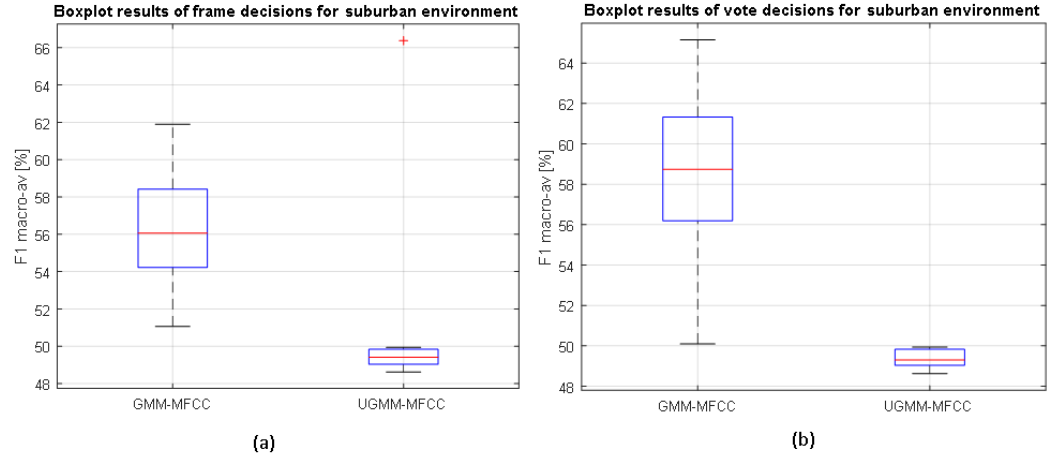
Figure 4. Boxplots of the classifiers’ performance at the ( a ) frame level and ( b ) high level on the suburban environment considering the binary-based GMM and UGMM classifiers and MFCC features, as well as following a leave-one-out cross-validation